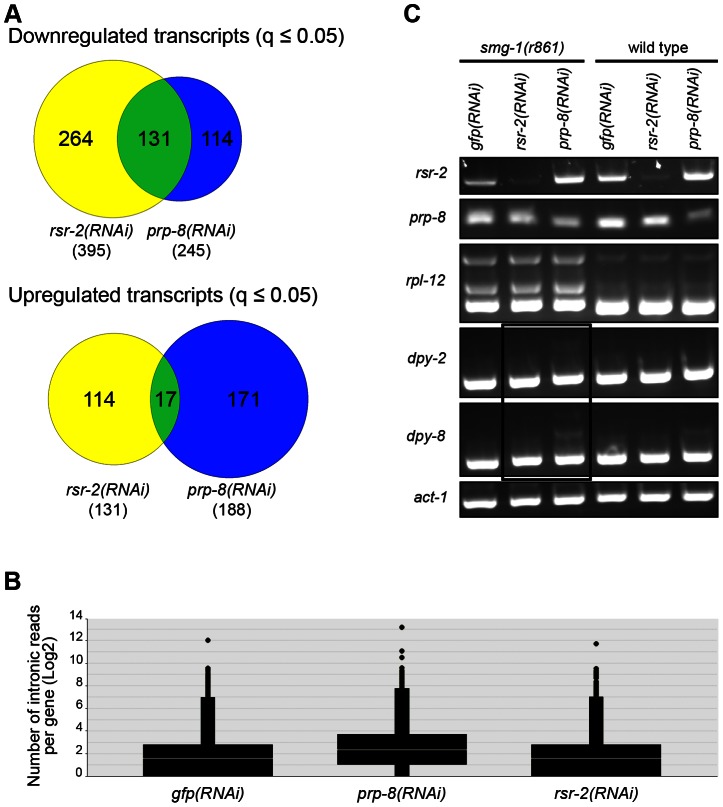
RNA-Seq of rsr-2(RNAi) and prp-8(RNAi) L3 animals.(A) Venn diagrams of down- and up-regulated transcripts in rsr-2(RNAi) (yellow) and prp-8(RNAi) (blue) L3 animal populations. Overlapping transcripts between the two samples are represented in green. (B) Graph representing the abundance of RNA-Seq reads mapped in intronic regions without internal genes corresponding to control gfp(RNAi), prp-8(RNAi), and rsr-2(RNAi) animals. (C) Semiquantitative RT-PCR of wild type and smg-1(r861) worms treated with gfp RNAi control, rsr-2 RNAi and prp-8 RNAi. rpl-12 was used as a positive control for intron retention in NMD-defective animals. act-1 was used as an endogenous control. The black box indicates the accumulation of aberrant mRNAs for dpy-2 and dpy-8 in the smg-1(r861); prp-8(RNAi) sample, but not in the smg-1(r861); rsr-2(RNAi) sample.